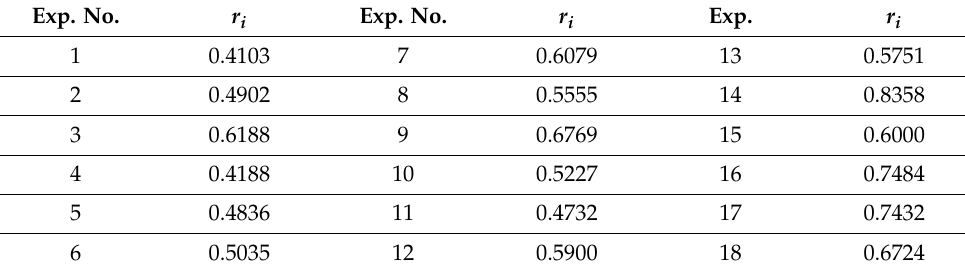
Table 23. Gray correlation grade of each group of experiments. Exp.